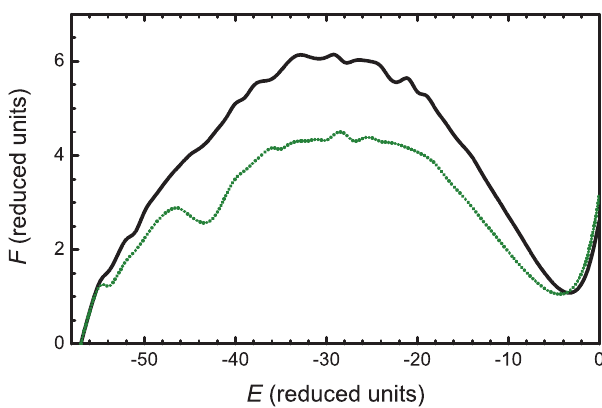
Figure 3. Examples of the free energy profiles F obtained for two of the circular permutants in family H. See text for details.